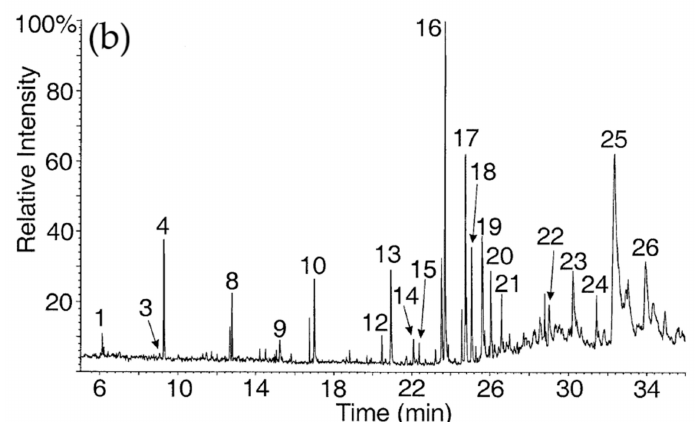
Figure 12. Total ion chromatograms of products formed during pyrolysis of ( a ) synthetic eumelanin standard (DA-melanin) and ( b ) synthetic pheomelanin standard (CDA- melanin). Peak designation: (1) benzene, (2) pyridine, (3) 1H- pyrrole, (4) methylbenzene, (5) and (6) 2-methylpyrrole or 3-meth- ylpyrrole, (7) methylpyridine, (8) ethenylbenzene, (9) phenol, (10) 4-methylphenol, (11) benzyl nitrile, (12) isoquinoline, (13) indole, (14) 4-hydroxybenzothiazole, (15) methylindole, (16) 2H-1,4-ben- zothiazin-5-one, (17) 7-methyl-2H-1,4-benzothiazin-5-one, (18) 4-hydroxy-6-ethyl-benzothiazole, (19)-(21) not identified, (22) and (23) thiazolo [4,5-f]isoquinoline or thiazolo[5,4-f]isoquinoline, (24) 2-methyl-thiazoloisoquinoline, (25) 1H[1]benzothiopyrano[3,4-d]imidazol-4-one, (26) not identified. Reproduced by permission from Springer Nature, Journal of the American Society for Mass Spectrometry, GC / MS analysis of thermally degraded neuromelanin from the human substantia nigra. Dzierzega-Lecznar A, Kurkiewicz S, Stepien K, Chodurek E, Wilczok T, Arzberger T, Riederer P, Gerlach M. License no. 4643461452547; 2004 Jun 1;15(6):920-6.